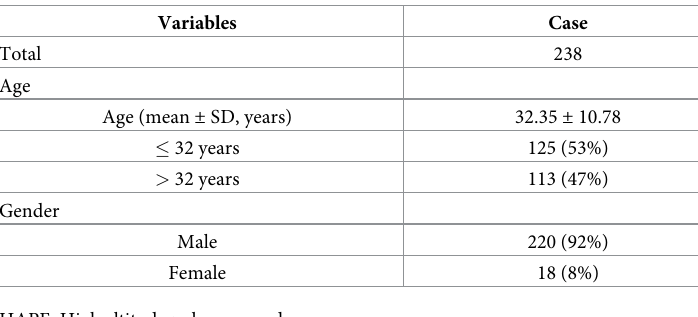
Table 3. Characteristics of patients with HAPE and control